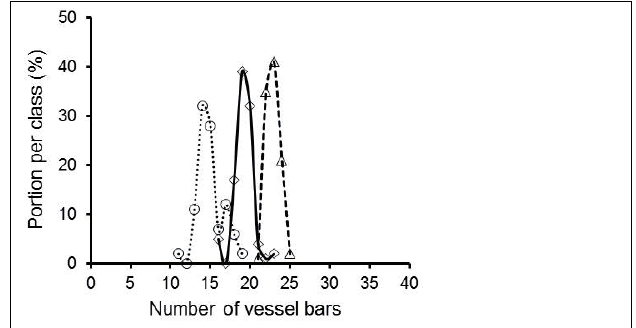
Fig. 4: Class size distribution (%) of the number of vessel bars per perforation plate in the xylem of the phenotypes “Amarelinha” (rough dotted line), “Cinza” (fine dotted line), and “Sassafras” (full line). Class size: 1. 500 measurements per phenotype.